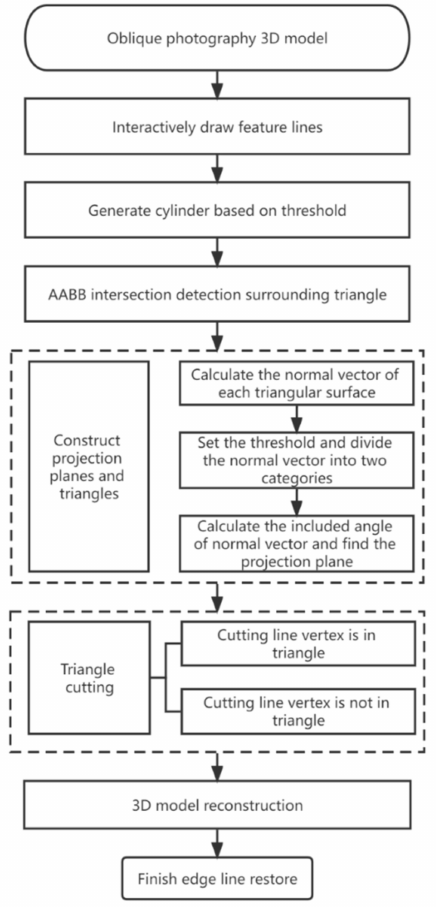
Figure 1. Flow chart of edge line